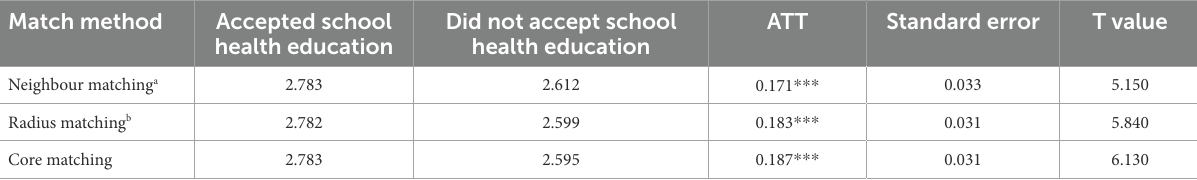
TABLE 3 Robustness test: propensity score matching (PSM). Match